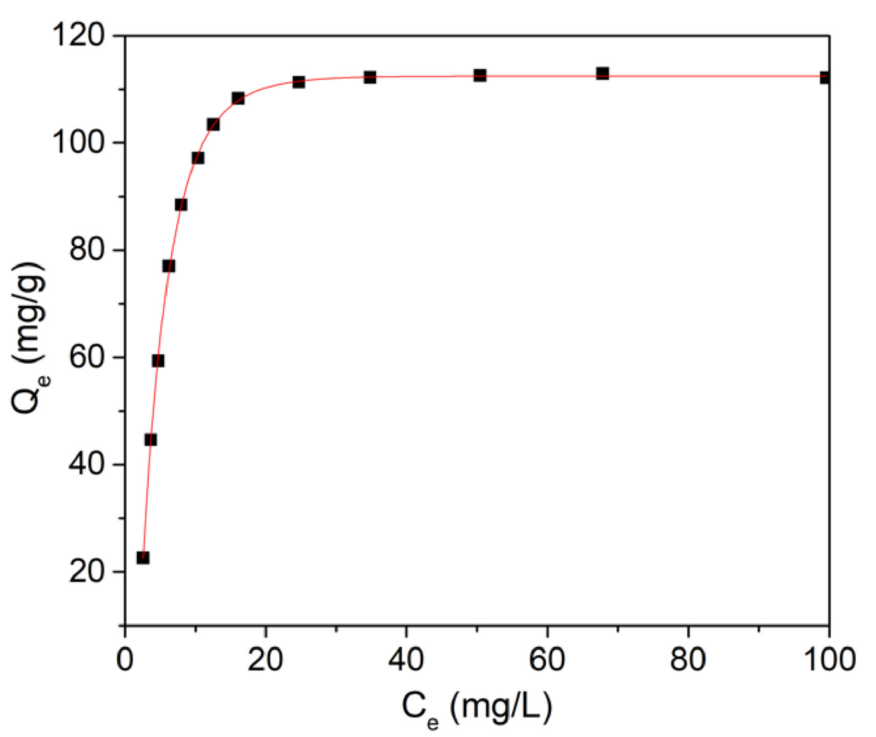
Figure 7. Graphical representation of the amount of material adsorbed at equilibrium by the equi- librium concentration for the adsorption of Pb 2+ from contaminated aqueous solutions using HAp- CTAB